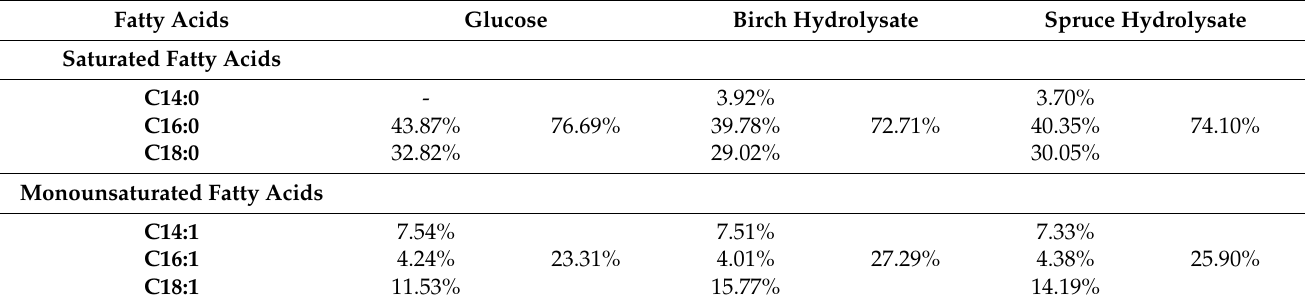
Table 3. Fatty acid profile of lipids obtained from heterotrophically cultivated Pseudanabaena sp. and analyzed by gas